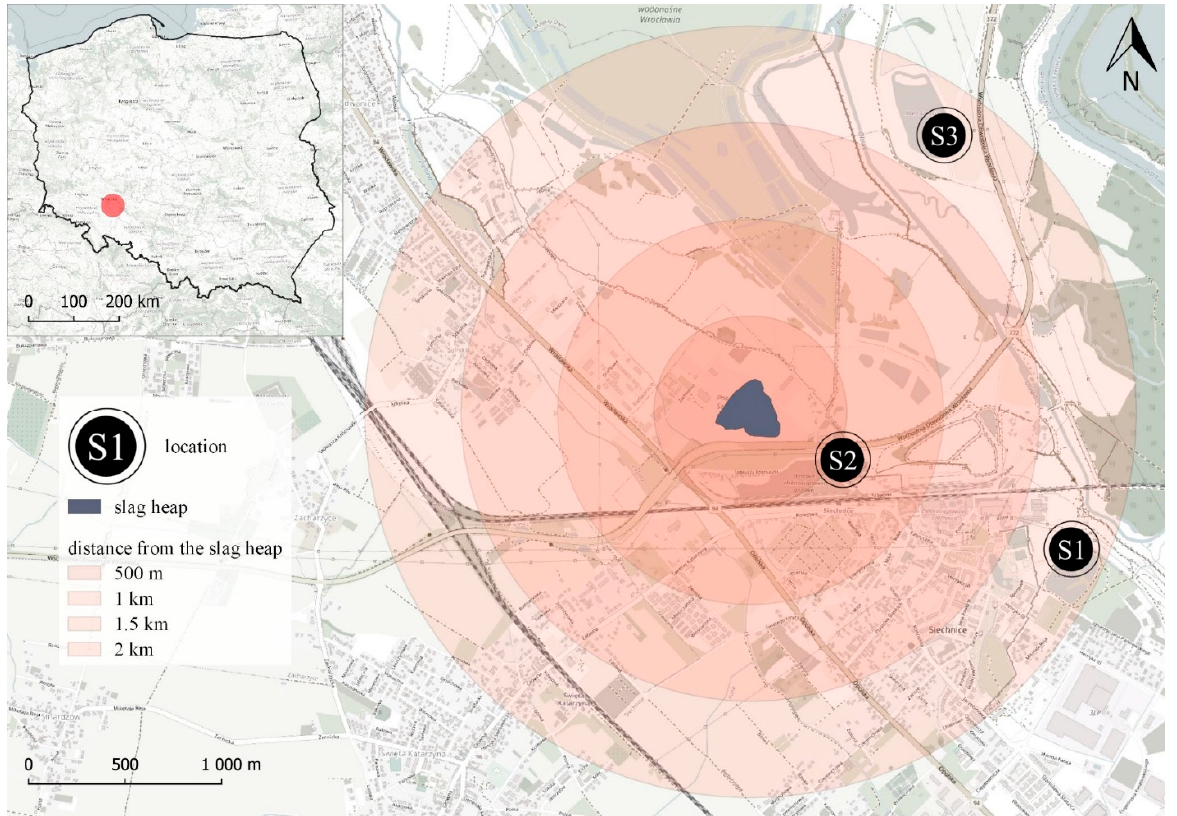
Figure 1. Location of postmetallurgical slag heap and sample sites (S1, S2, S3). Source: https://www.openstreetmap.org/ (accessed on 27 September 2022). S1–S3: sample sites.